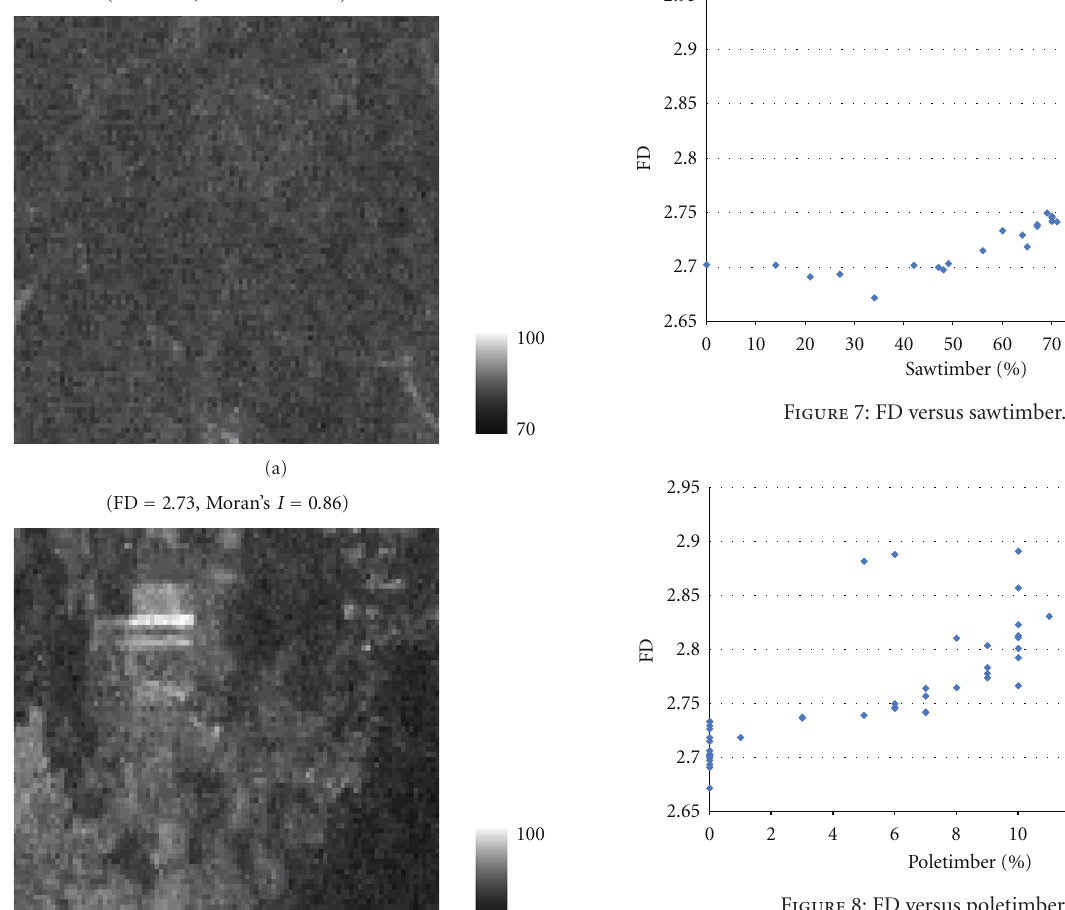
Figure 8: FD versus